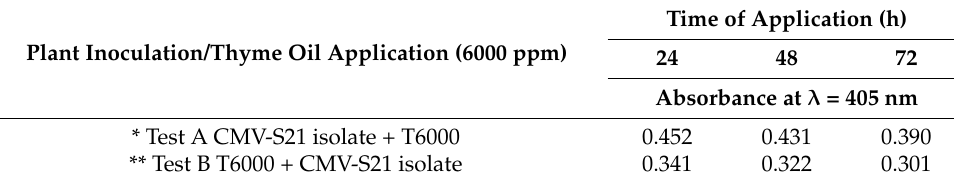
Table 4. Results of DAS-ELISA for the Ch. quinoa plants inoculated with the CMV-S21 isolate with the addition of thyme EO at different times of treatment.